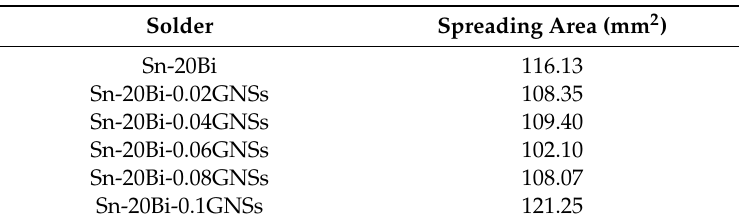
Table 1. Spreading area of Sn-20Bi solder with various content of graphene nanosheets (GNSs) on Cu substrate.